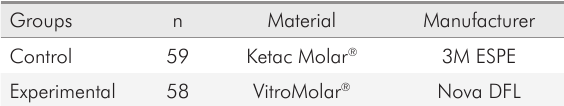
Table 1. Distribution of groups according to the material of the